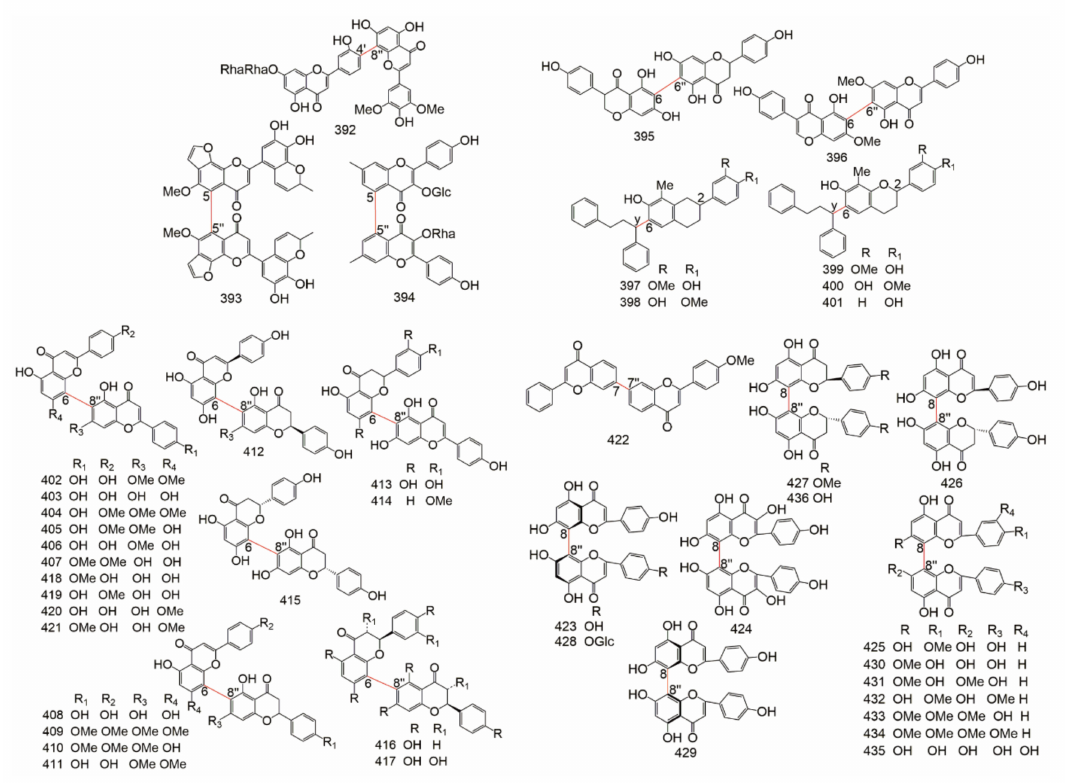
Figure 8. The structure of 4 (cid:48) -8 (cid:48)(cid:48) , 5-5 (cid:48)(cid:48) , 6-6 (cid:48)(cid:48) , 6- γ , 6-8 (cid:48)(cid:48) , 7-7 (cid:48)(cid:48) , and 8-8 (cid:48)(cid:48) type biflavonoids.